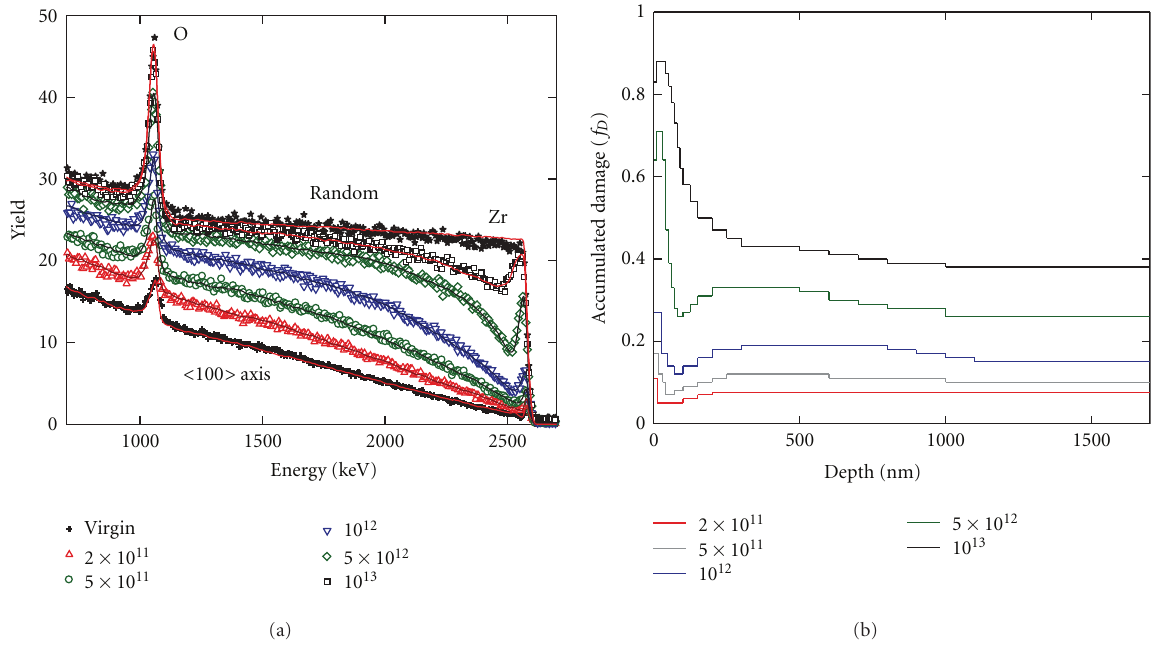
Figure 6: (a) RBS spectra recorded on cubic zirconia crystals irradiated at RT with 940-MeV Pb ions in random (stars) and (cid:4) 100 (cid:5) -aligned (other symbols) directions (ion fluences are given in cm − 2 ). Energy of analyzing He beam: 3.07 MeV. Solid lines are fits to experimental data with the McChasy code [21, 22]. (b) Accumulated damage ( f D ) as a function of depth extracted from the fits to experimental RBS data for cubic zirconia crystals irradiated with 940-MeV Pb ions at the indicated